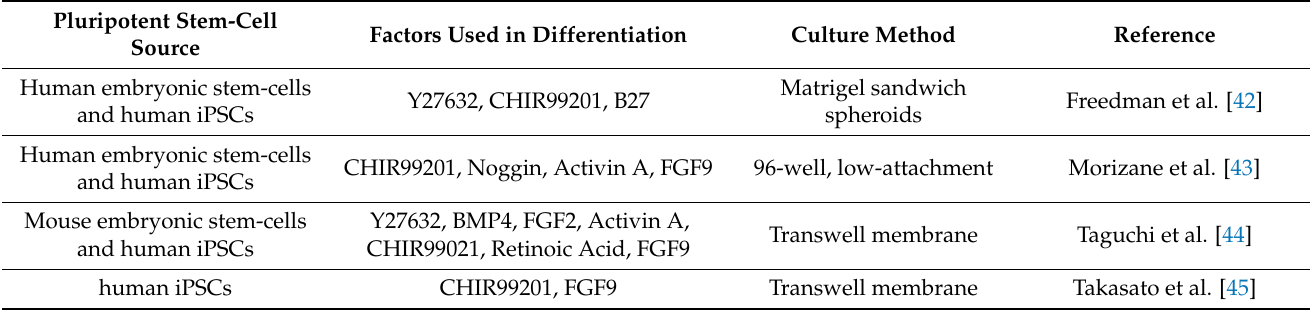
Table 1. Overview of well-established protocols for generation PSC-KOs. The cell source, differentiation factors and culture methods are summarized and presented for each